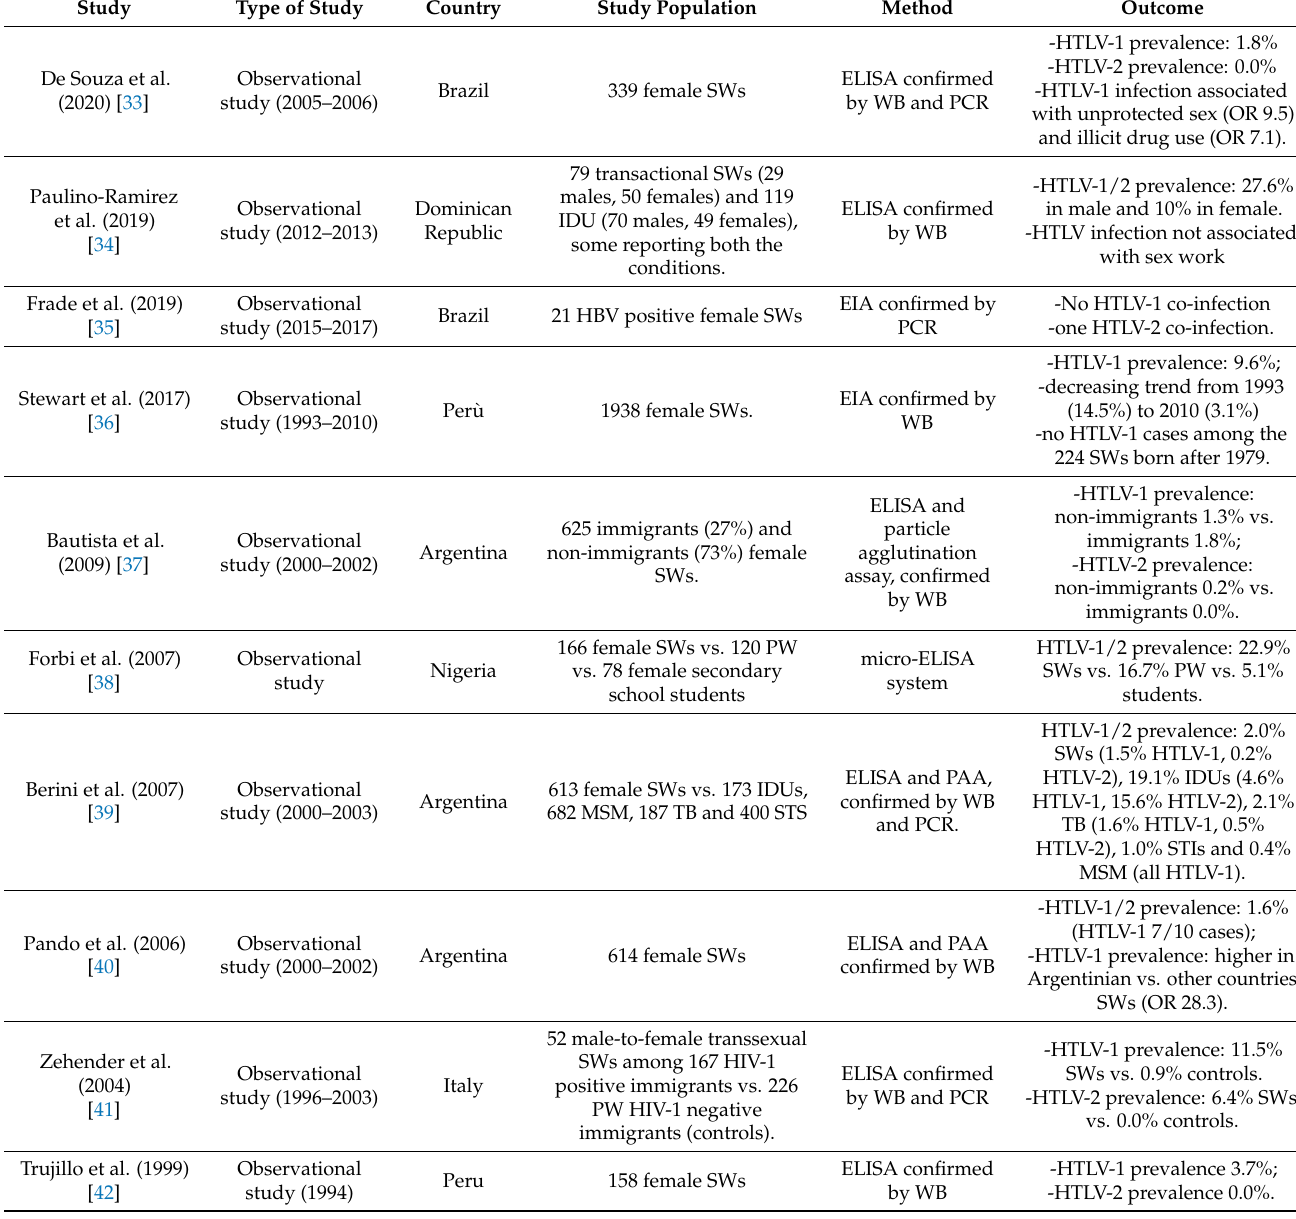
Table 3. Studies on work-related HTLV-1/2 infection in sex workers